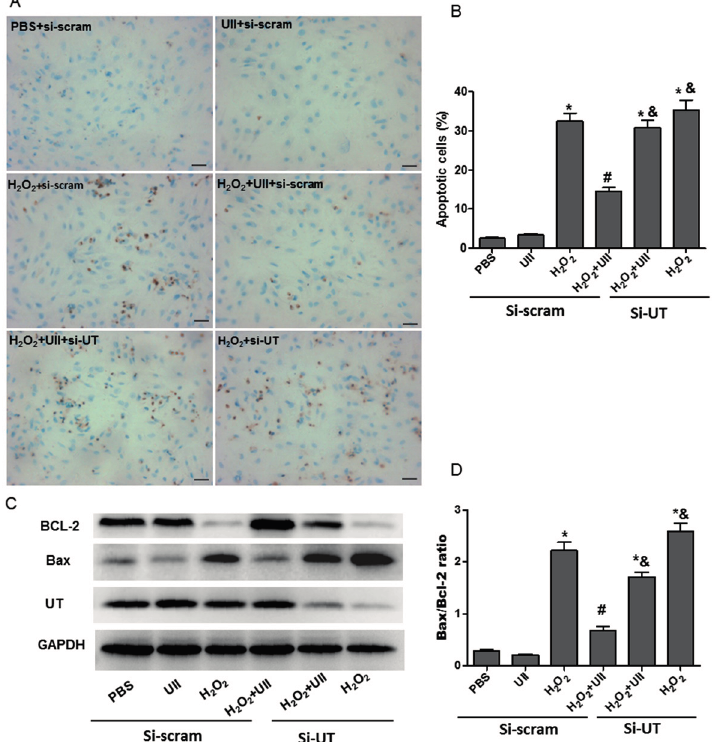
Figure 1. UII prevents cardiomyocytes from apoptosis induced by H 2 O 2 . ( A ) Detection of apoptotic cardiomyocytes (brown nuclei) by TUNEL staining; ( B ) Quantitative analysis of TUNEL positive cells, the data were represented as the percentage of TUNEL positive nuclei; ( C ) Western blot analysis of the level of Bax and Bcl-2 proteins; ( D ) Quantitative analysis of the ratio of Bax/Bcl-2 expression. The cultured cardiomyocytes were transfected with siRNA-UT (si-UT) or siRNA-scramble (as control) for 48 h, then treated with UII (0.1 μ M) or PBS for 30 min and exposed to 100 μ M H 2 O 2 for 24 h. si-UT: Cardiomyocytes were transfected with siRNA-UT. Cardiomyocytes were transfected with siRNA-scramble (si-scram) as control. Values are mean ± SEM. * p < 0.05 vs. PBS group; # p < 0.05 vs. H 2 O 2 group; & p < 0.05 vs. H 2 O 2 + UII group. Bar = 25 μ m. All experiments were repeated independently at least three